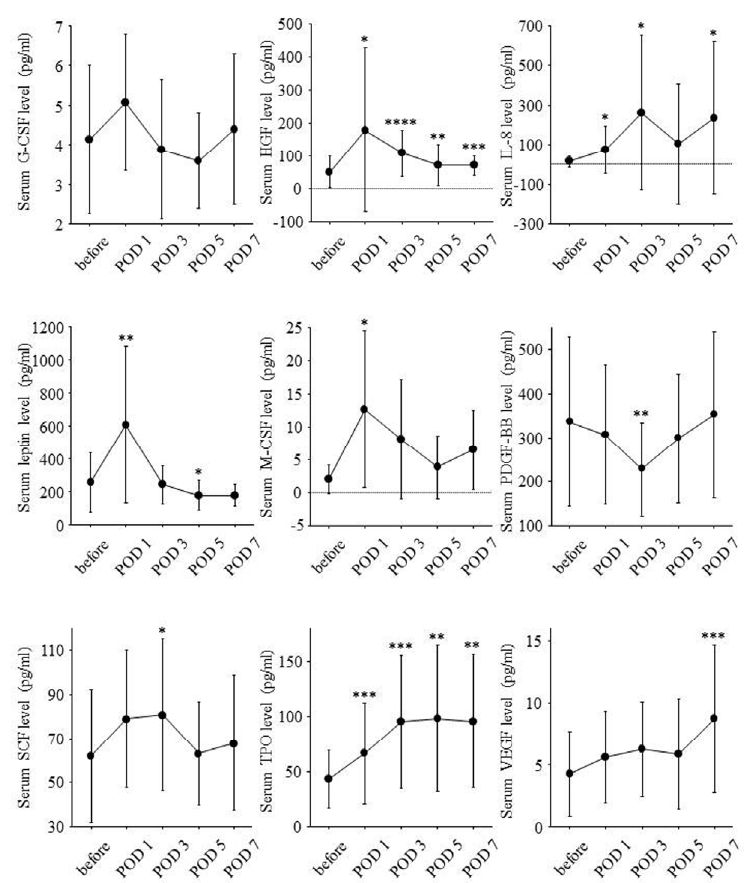
Figure 4. Serial changes of serum levels of nine growth factors during the clinical course. Serum levels of each growth factor before hepatectomy and on POD 1, 3, 5 and 7 were expressed as mean ± standard deviation. Before: before partial